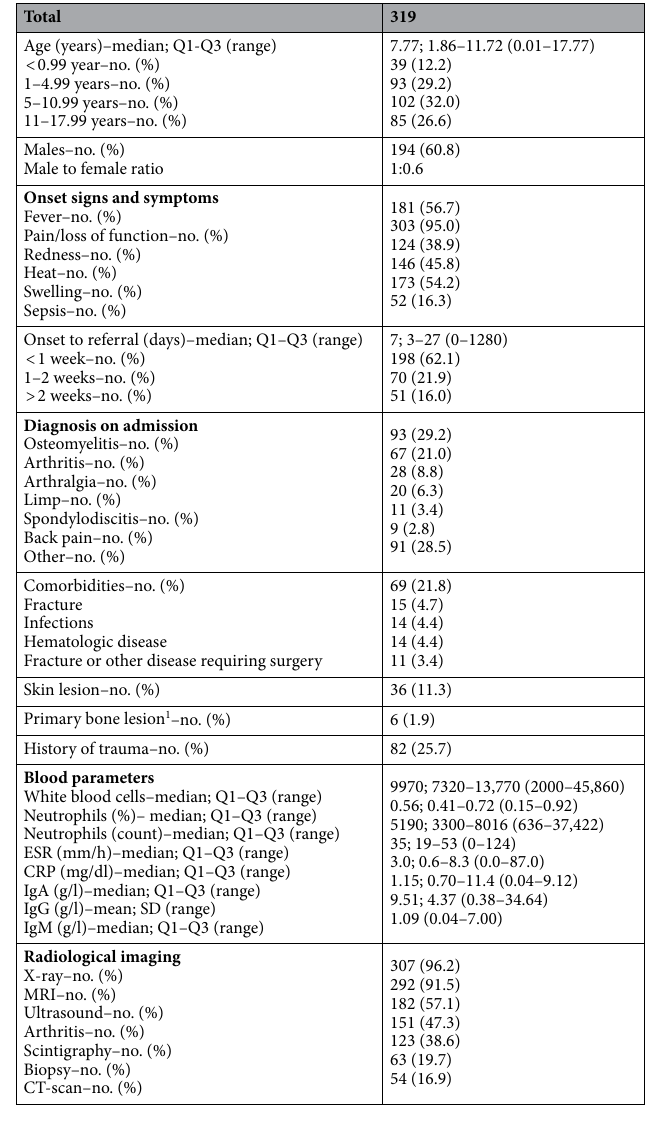
Table 1. Clinical and demographic characteristics of the study sample. 1 In more detail: avascular necrosis of the femoral head ( n = 1); diffuse osteopenia ( n = 1); aneurysmal bone cyst ( n = 1); osteochondroma ( n = 1); Blount disease ( n = 1), Kohler disease ( n =